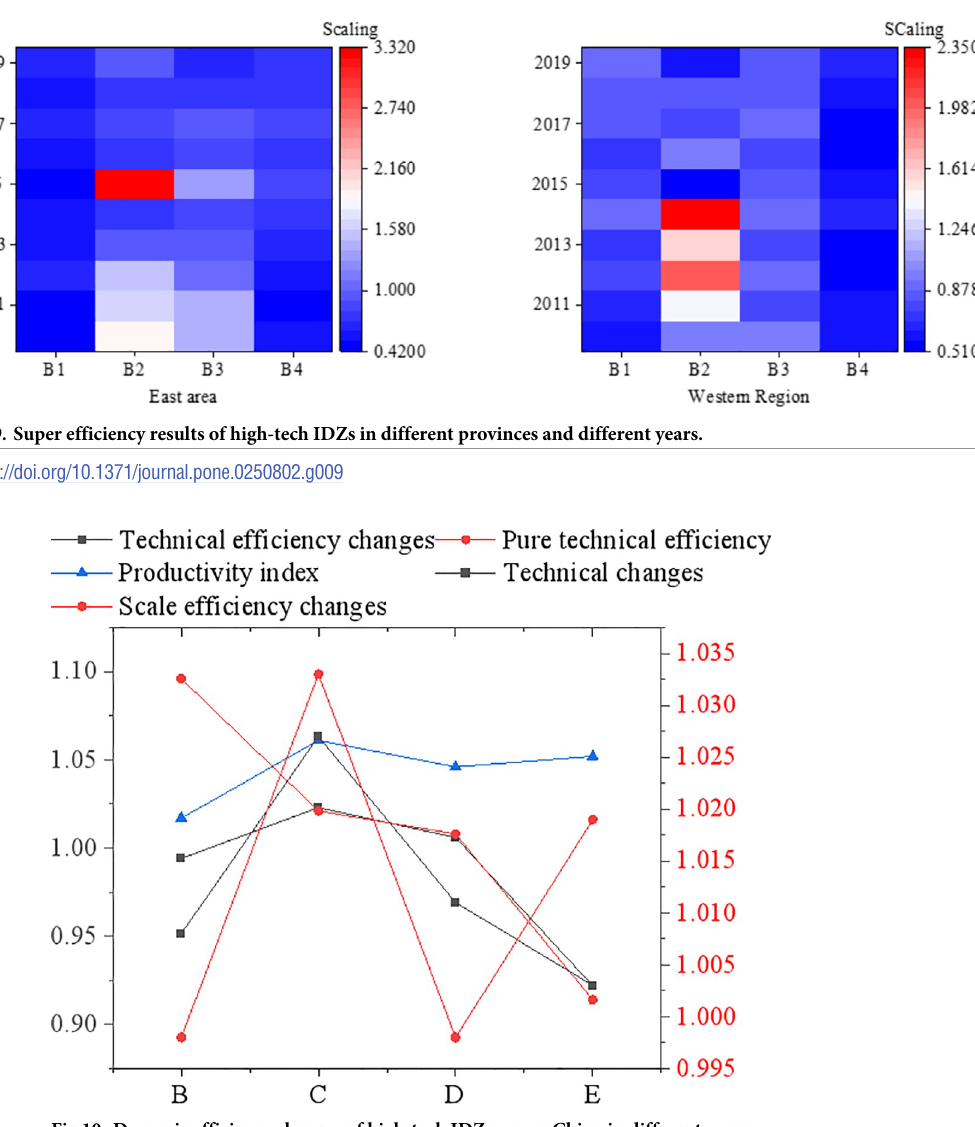
PLOS ONE | https://doi.org/10.1371/journal.pone.0250802 June 22,